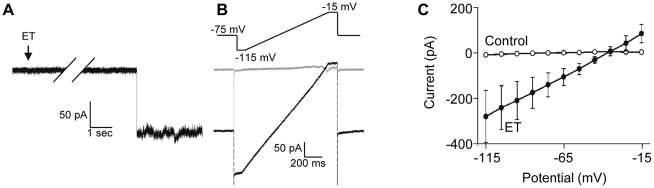
Membrane current induced by ET in granule cells.Granule cells were maintained under voltage clamp using the whole cell configuration. A, a recording taken from a series of 15 independent experiments (granule cells hold at −75 mV) during which slices were preincubated for 10 min with TTX (10−5 M), TEA (1 mM), 4-AP (2 mM), CNQX (10−5 M) and bicuculline (10−5 M) before application of ET (10−7 M, arrow). Note the abrupt large inward current step that manifests action of ET on the membrane characteristics. B, During the course of the same series of experiments, membrane holding potential was changed from −75 mV to −115 mV, followed by depolarizing ramps from −115 mV to −15 mV, before returning to −75 mV. This paradigm was performed before application of ET and after the toxin had induced an abrupt change in the whole cell current, as illustrated in A. Typical currents (before: grey; after ET: black) are shown. C) Currents traces were pooled under control (before ET) or after ET and averaged, to build the I =  f(V) relationship.